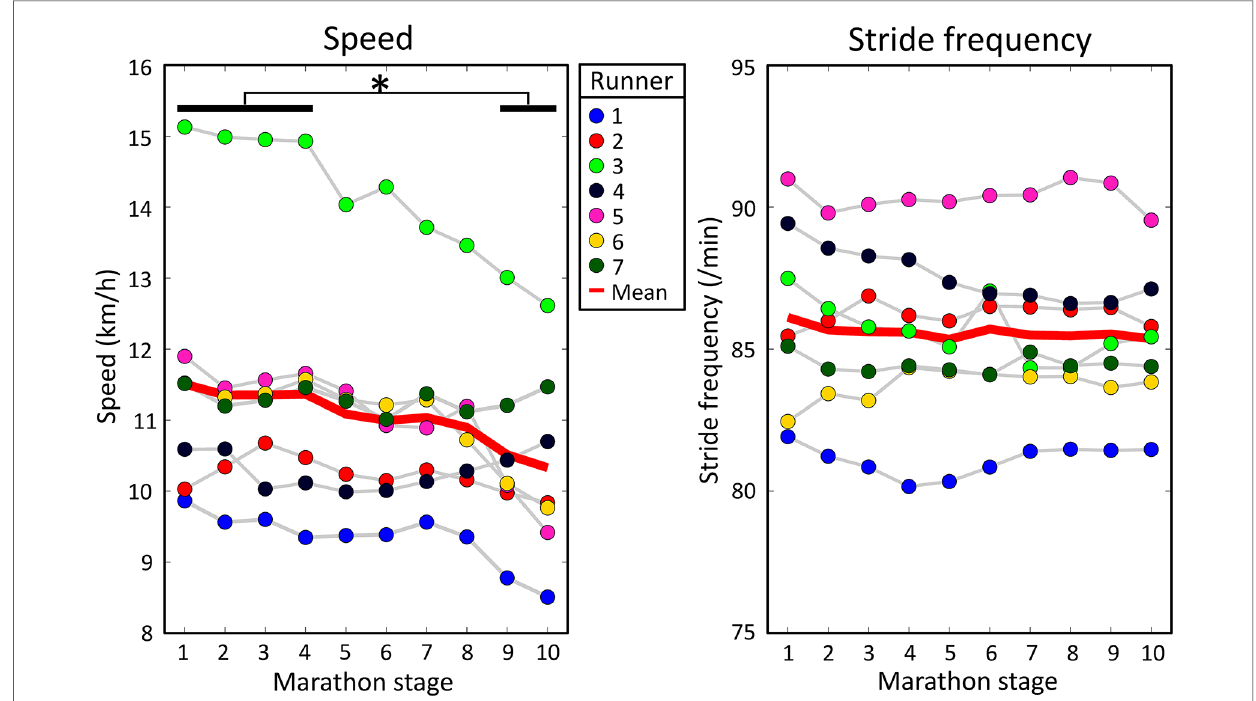
FIGURE 3 Mean speed and stride frequency for every runner during all marathon stages. The solid red lines show the group means. A signi fi cant effect of marathon stage on speed was found. Signi fi cant results from post hoc analyses are shown by an asterisk at the top of the fi gure.